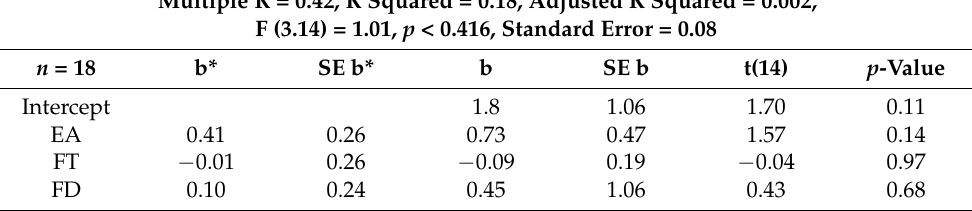
Table 6. Regression analysis for the underwater